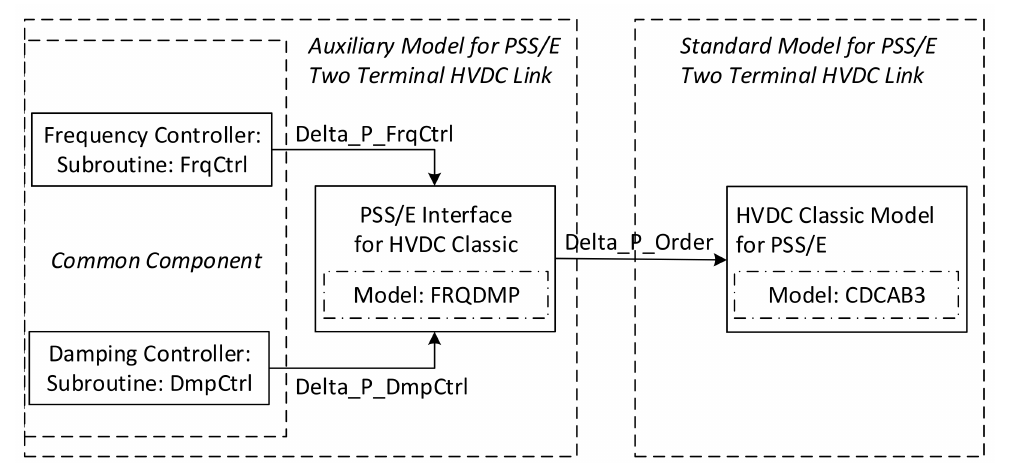
Figure 2. Structure of the model design of the frequency and damping